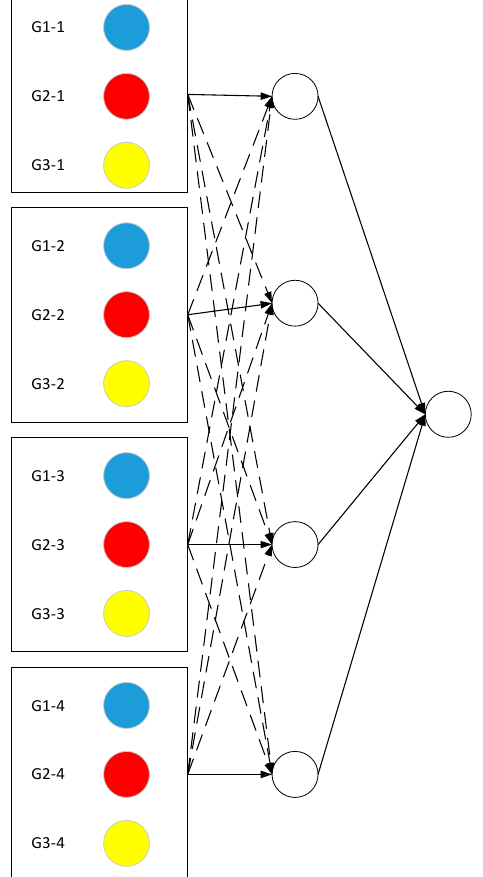
Figure 11. Neural network structure.